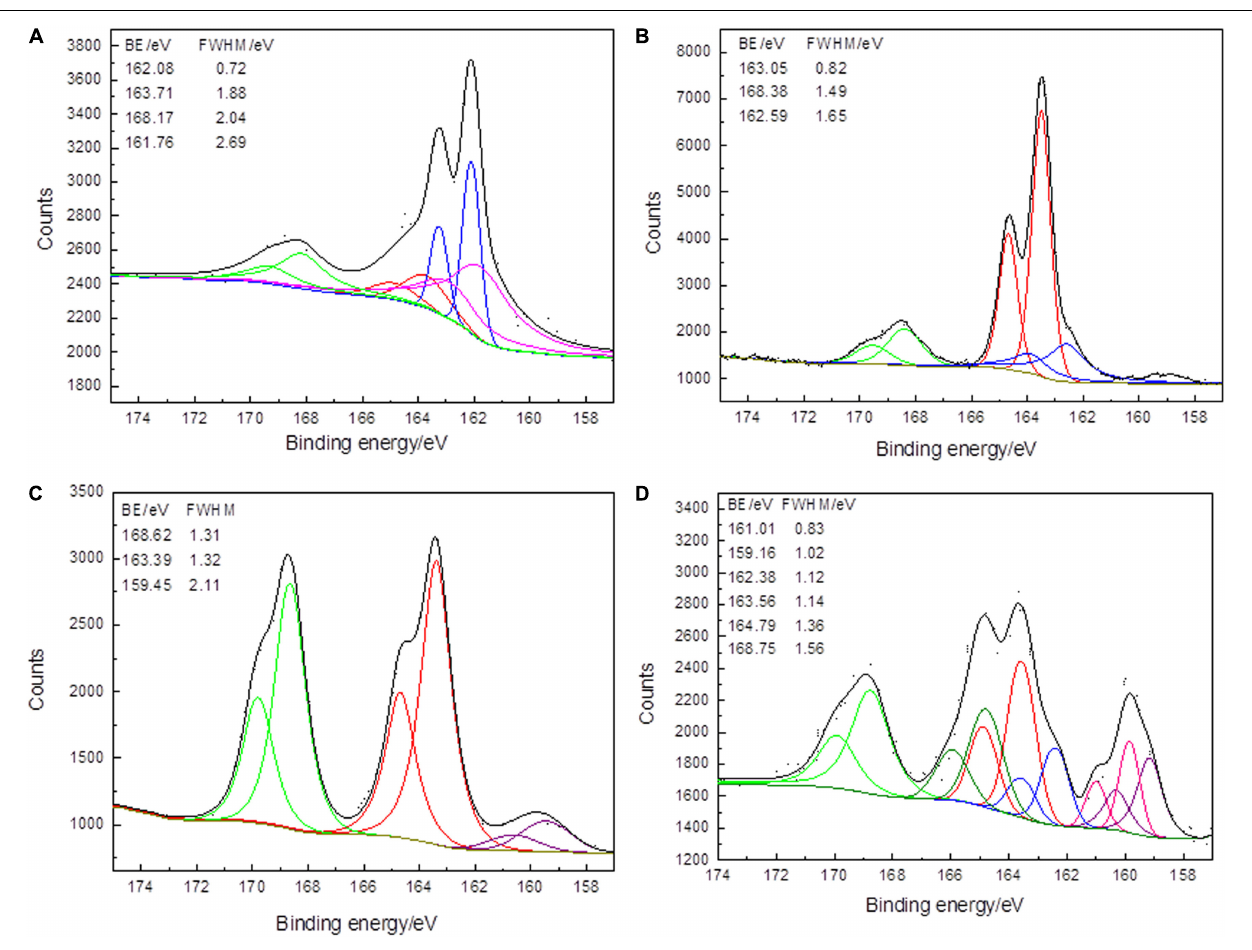
FIGURE 4 | XPS S 2p spectra of arsenopyrite before (A) and after bioleaching with mixed culture for 2 days (B) , 6 days (C) , and 10 days (D) at 45 ◦ C and initial pH 1.5. Short dots present the experiment data. Fits to data and the background are in black and dark yellow curves. The curves in red, blue, green, olive, pink, and purple present the spin-orbit split peaks of S n2 - , As–S, SO 42 - , intermediate S–O, mono-sulfides, and